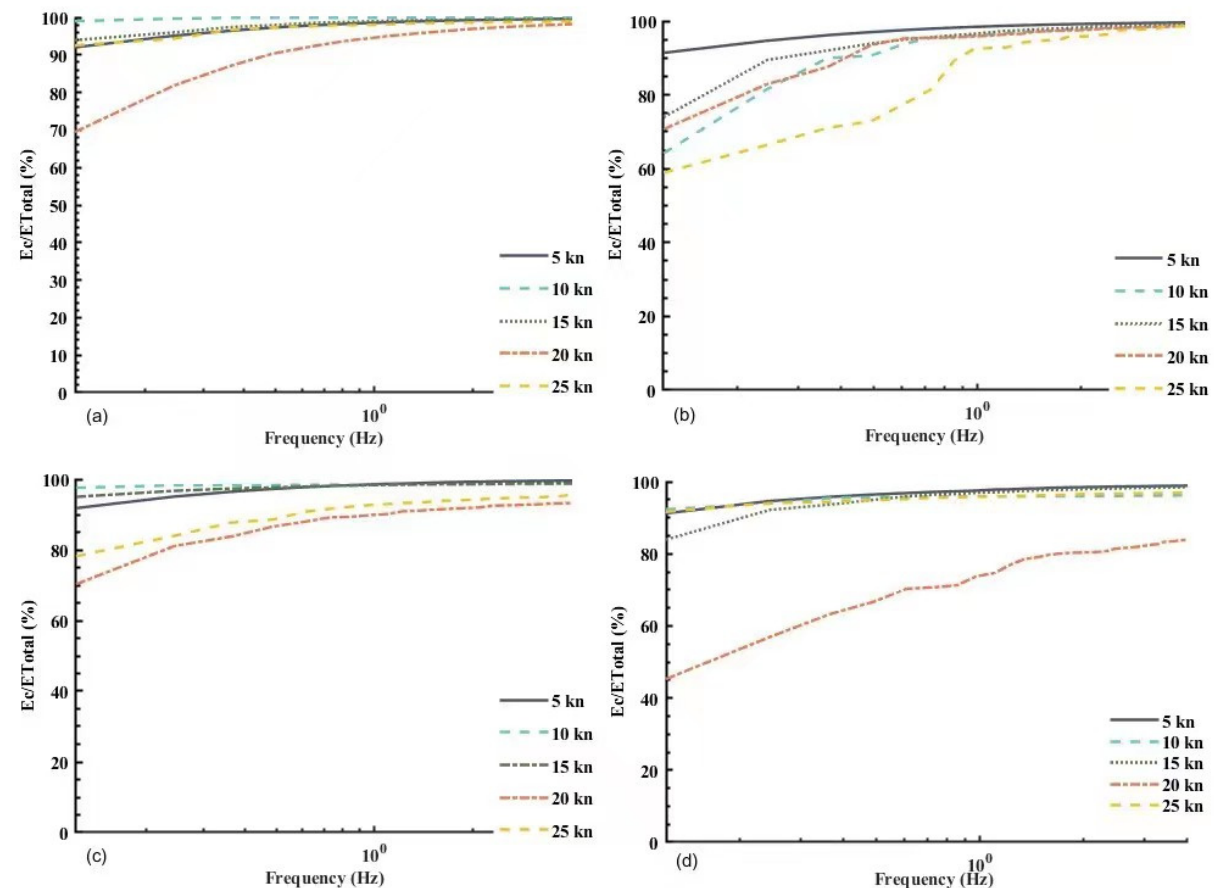
Figure 7. Distribution of accumulated energy with frequency. ( a ) Distribution of accumulated energy of the longitudinal component of the bow sensor; ( b ) Distribution of accumulated energy of the transverse component of the bow sensor; ( c ) Distribution of accumulated energy of the longitudinal component of the stern sensor; ( d ) Distribution of accumulated energy of the transverse component of the stern sensor.